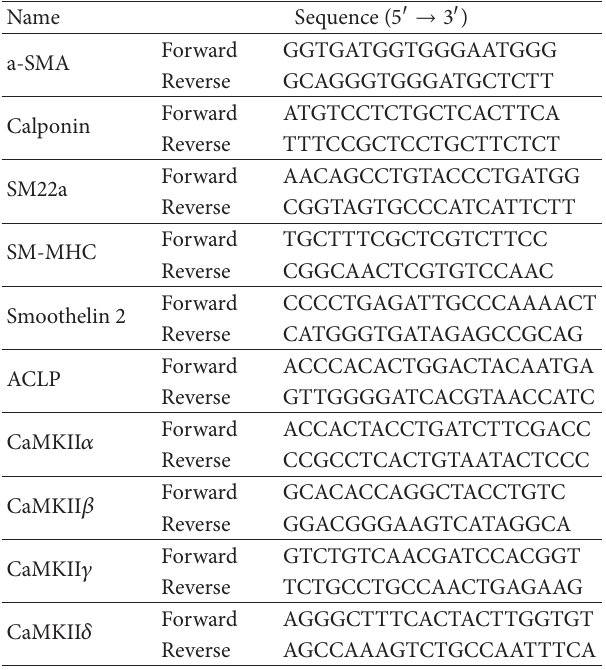
Table 1: qRT-PCR primer